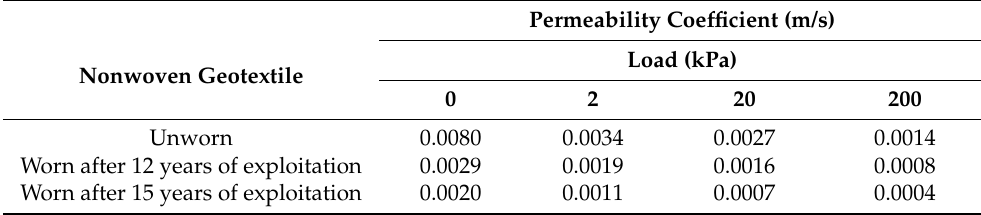
Table 8. Coefficients water permeability for nonwoven geotextiles exploited at the Radiowo landfill leachate drainage system (adapted from